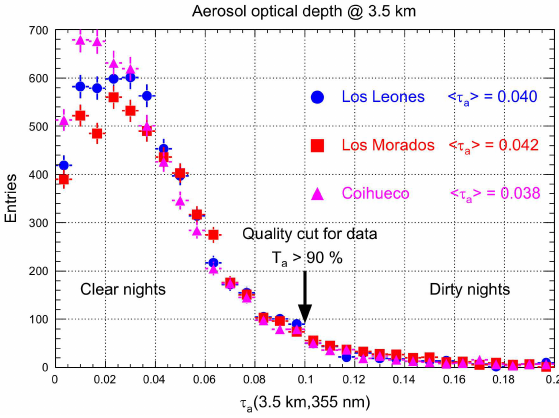
Figure 5. Distribution of VAODs at 3.5 km above ground level. The average aerosol attenuations (VAODs) are highlighted in the